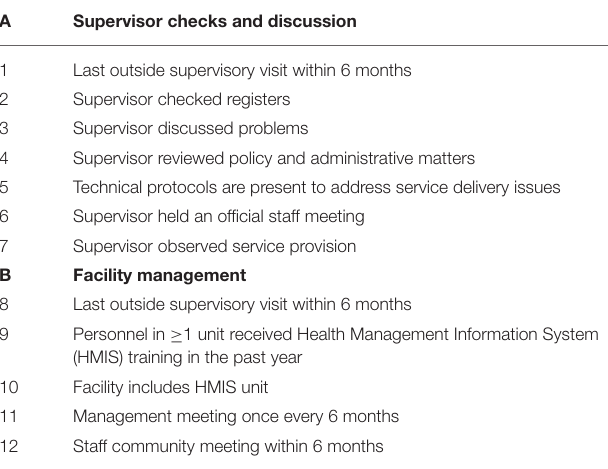
TABLE 5 | Components of management and supervision index.